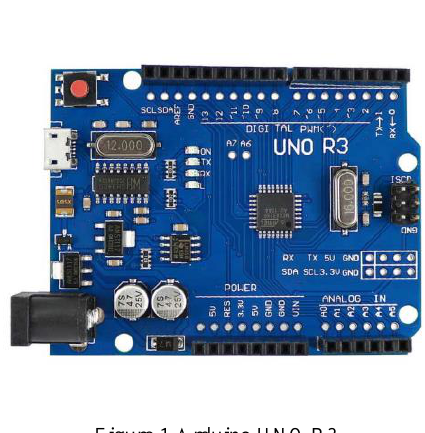
Figure 1 Arduino UNO R3